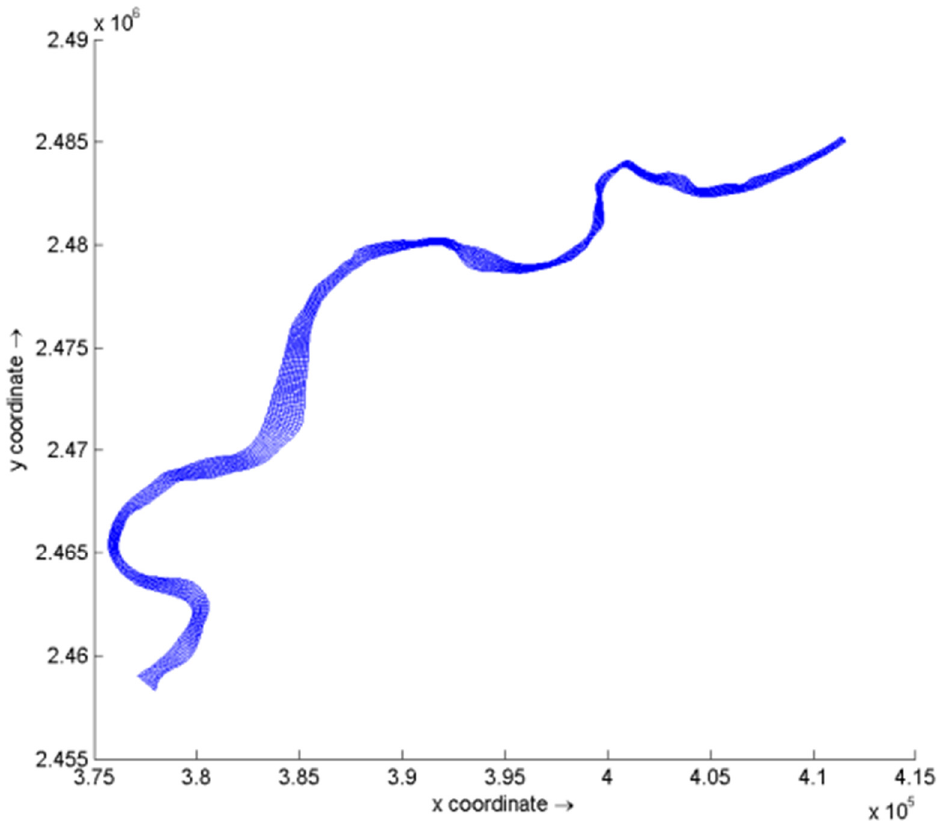
Figure 3. Hydrodynamic grid of the study area.